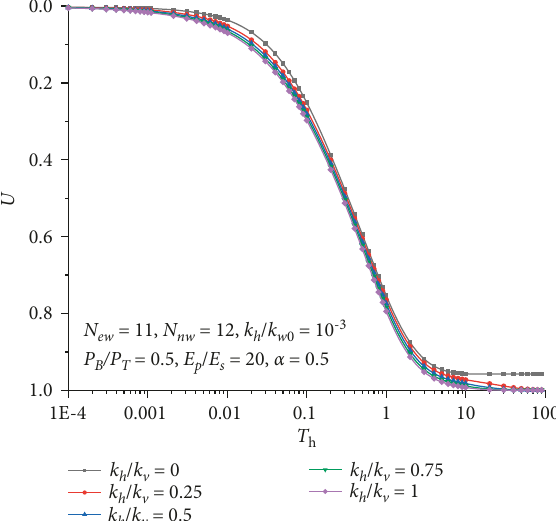
Figure 10: Influence of k v on average consolidation degree when H /